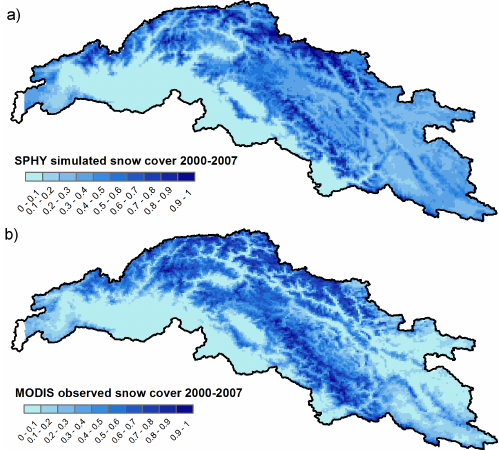
Figure 8. Observed and simulated average fractional snow cover in the upper Indus basin. The values represent the 9-year average for 46 (8-day) periods during 2000–2007.